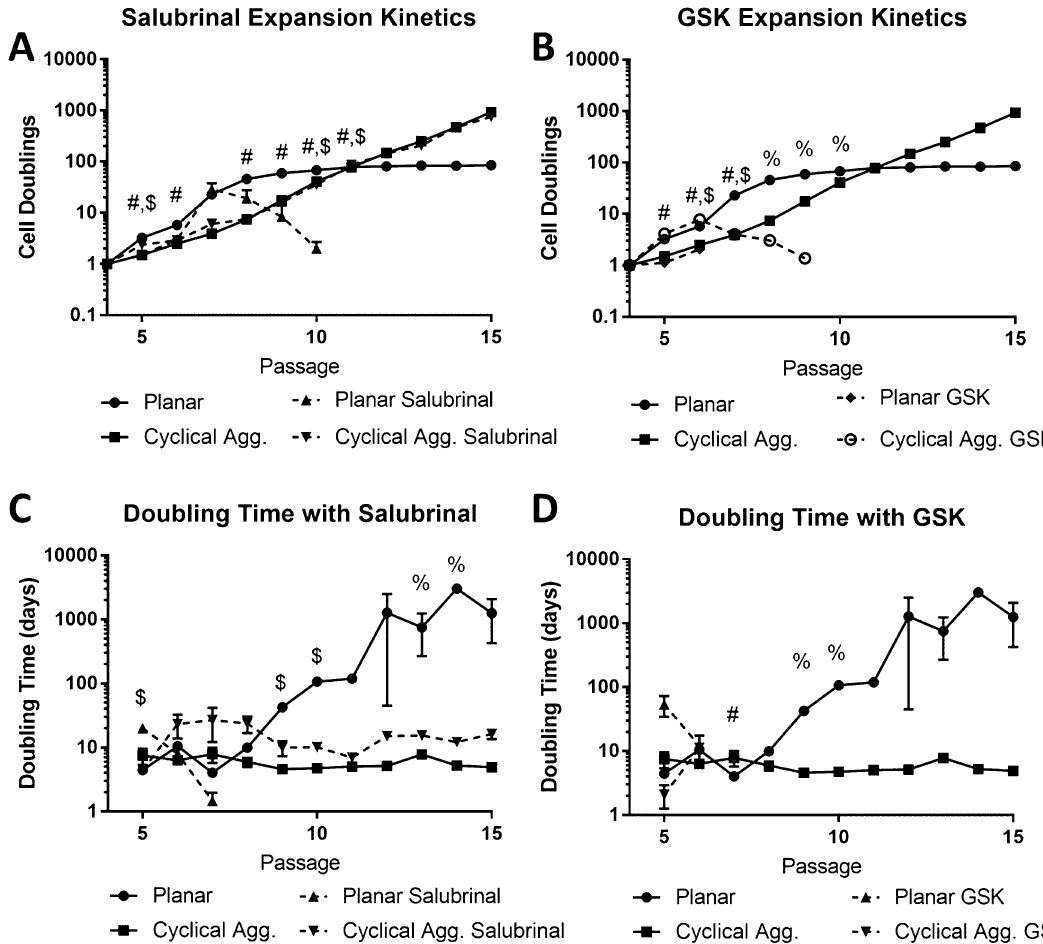
Figure 2. Integrated stress response (ISR) modulation shows that aggregation-induced signaling is responsible for maintenance of stem cell growth kinetics. Cell doublings under ISR response following treatments with ( A ) salubrinal (5 µM) and ( B ) GSK-2606414 (10 µM), which illustrate that inhibiting ISR results in accelerated cell death. Doubling time of ISR-modulated ASCs: ( C ) salubrinal (5 µM) and ( D ) GSK-2606414 (10 µM), revealing the ISR effect of cyclical aggregations on stem cell growth. Data represents the mean of at least three independent determinations; errors represent the standard error in the mean. # indicates p < 0.05 (planar vs. treatment), % indicates p < 0.05 (aggregation vs. treatment), $ indicates p < 0.05 (treated planar vs. treated